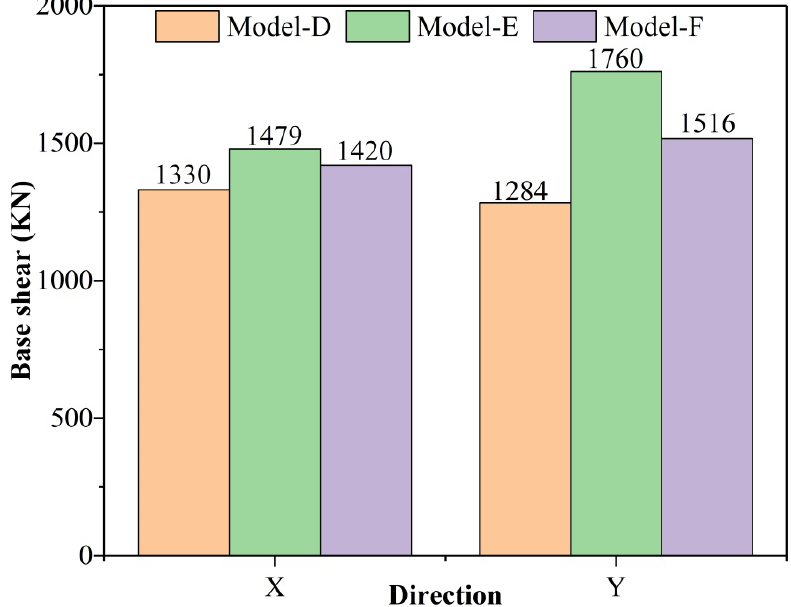
Figure 11. Aa comparison of max base shear of models.